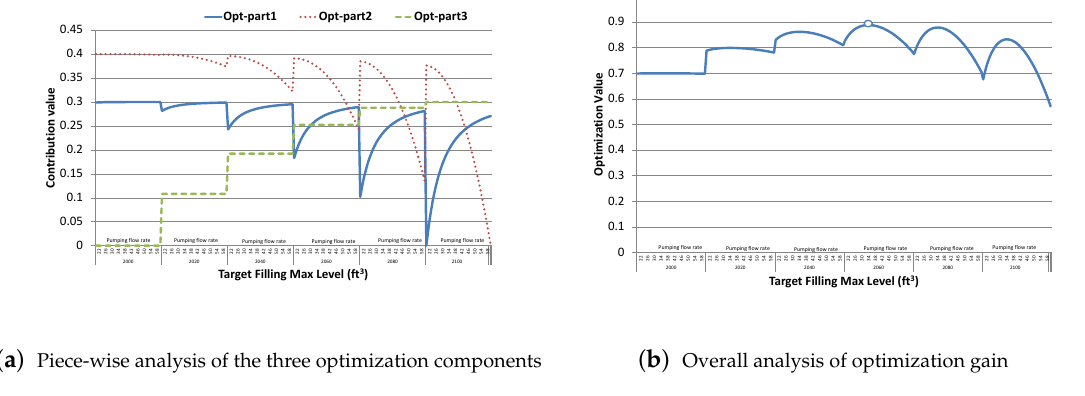
Figure 8. Analysis of revised optimization formula with global min–max duration and energy